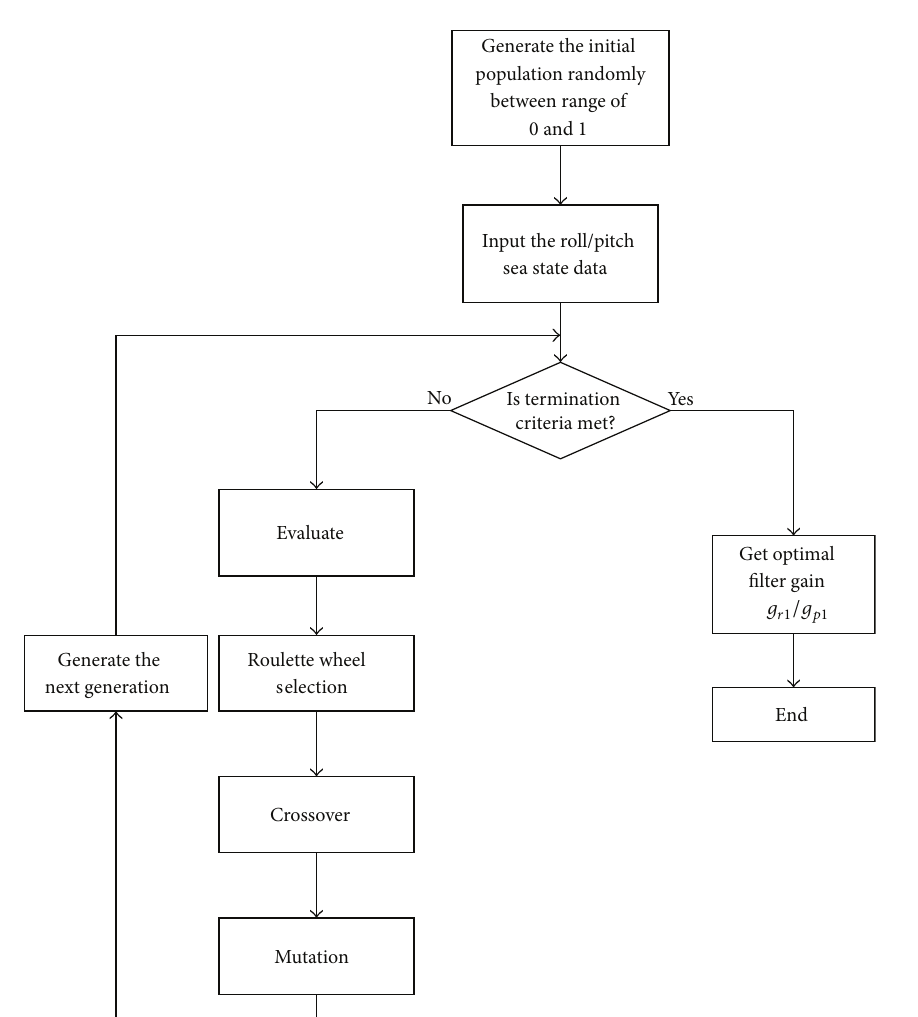
Figure 4: Flow chart of GA roll/pitch gain